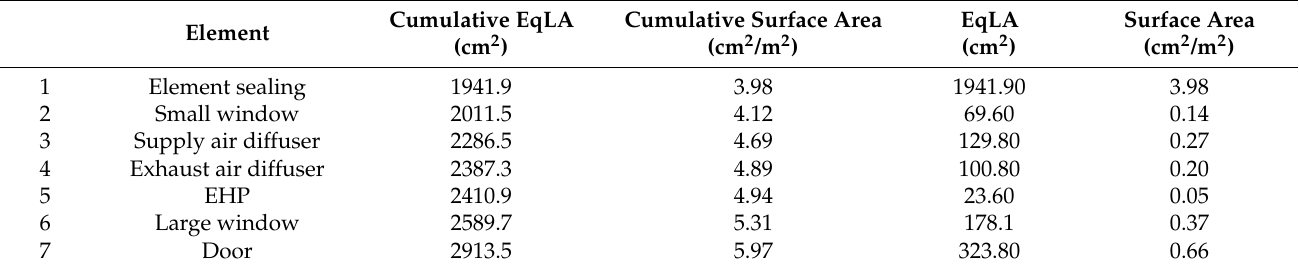
Table 5. Leakage area of the